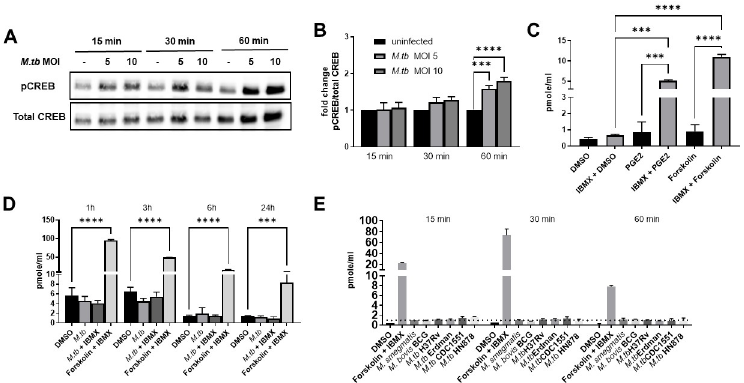
Fig 1. M . tb induces CREB activation independent of cAMP in human macrophages. MDMs were infected with M . tb H 37 R v by synchronized phagocytosis at the indicated MOI. A) Western blot was performed to detect levels of phosphorylated and total CREB protein at the indicated time points. WB is representative of n = 4 donors. B) Densitometry analysis was performed and ratios of pCREB/total CREB were determined. Data are cumulative ± SEM of n = 4 donors. One-way ANOVA with Tukey’s post-test. C) MDMs were stimulated with cAMP agonists PGE 2 or forskolin ± PDE inhibitor IBMX for 30 min. Data are representative ± SD of n = 4 donors. One-way ANOVA with Tukey’s post-test. D) cAMP levels in M . tb -infected (MOI 5) MDM lysates were determined. Graph is representative ± SD of n = 11 donors. One-way ANOVA with Tukey’s post-test. E) MDMs were infected with different strains of mycobacteria (MOI 5) or forskolin + IBMX as a control for cAMP production. Lysates were collected and analyzed for cAMP production. Dotted line indicates minimum level of detection for the assay. Data are representative ± SD of n = 2 donors; * p < 0.05, *** p < 0.001, **** p < 0.0001.